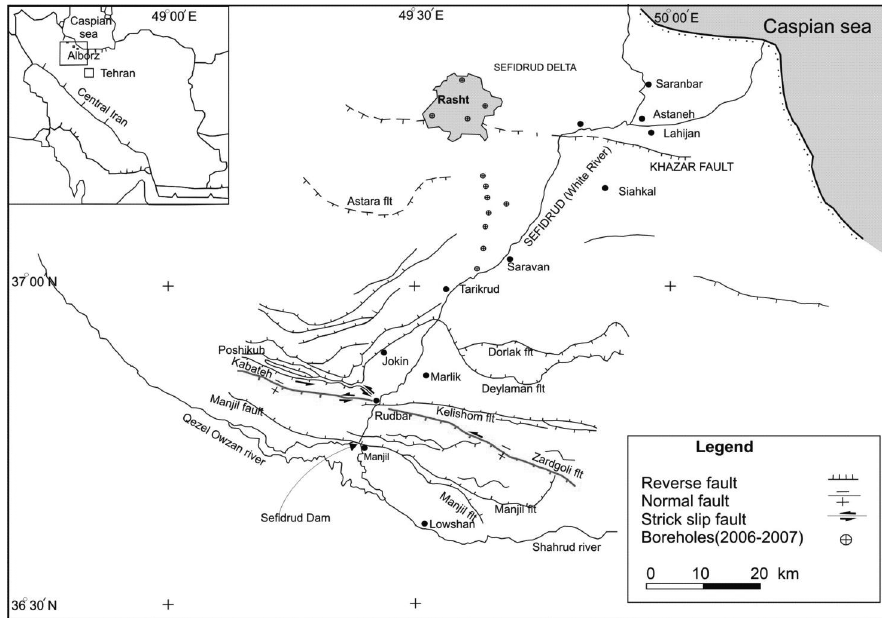
Fig. 1. Major faults, and the position of boreholes in Rasht